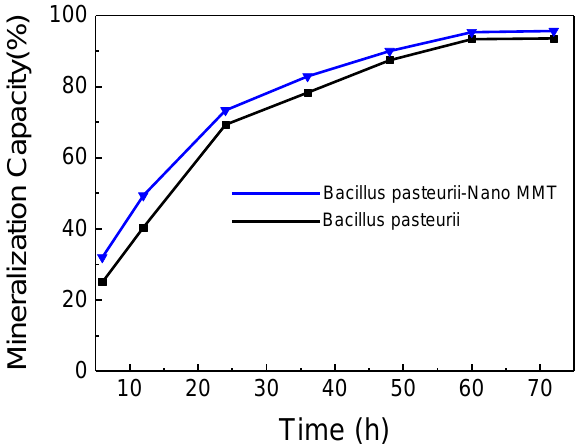
Figure 7. Mineralization efficiency of strontium ions in microbial mineralization systems.